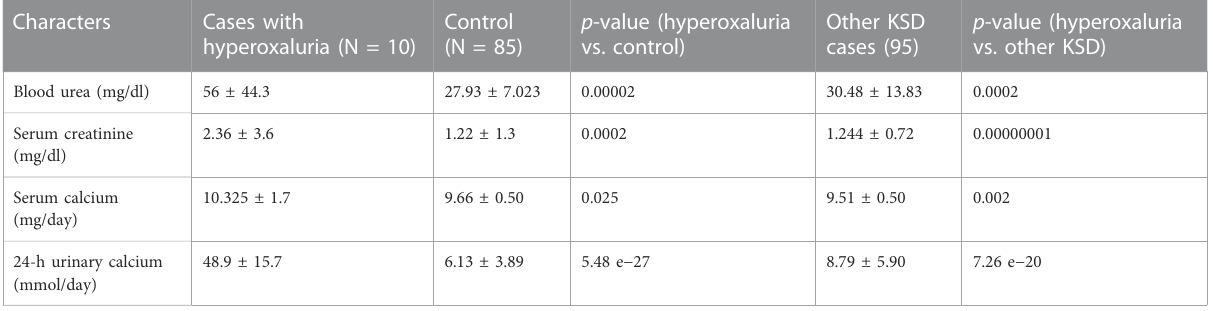
TABLE 3 Biochemical status of patients with Hyperoxaluria ( p < 0.05, denoted in italic along with the ‘ p ’ of p -value (as per convention) † At diagnosis; SD = Standard deviation). Characters